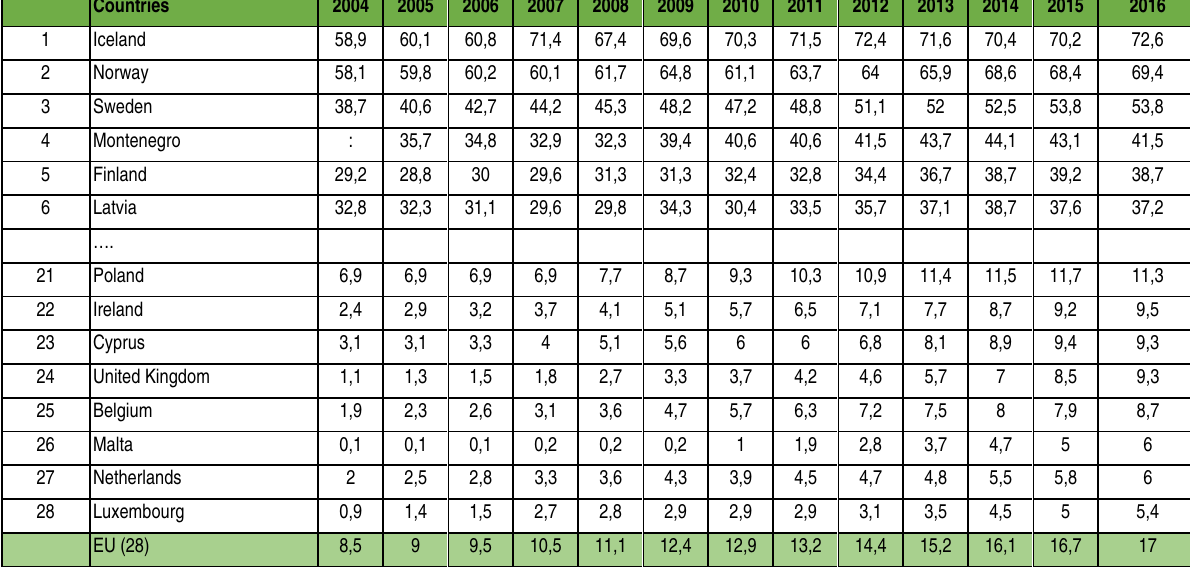
Table 1. Dynamics of share of renewable energy in gross final energy consumption in the EU